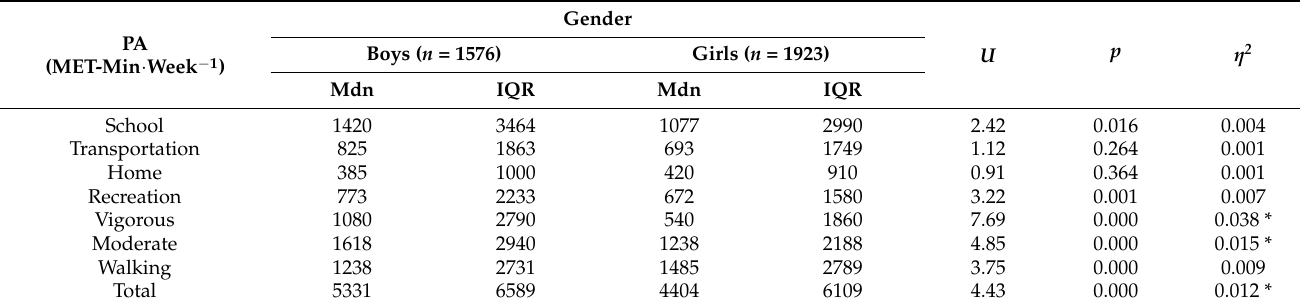
Table 2. Types of weekly physical activity (MET-min · week − 1 ) among Polish boys and girls using the International Physical Activity Questionnaire-Long Form (IPAQ-LF).